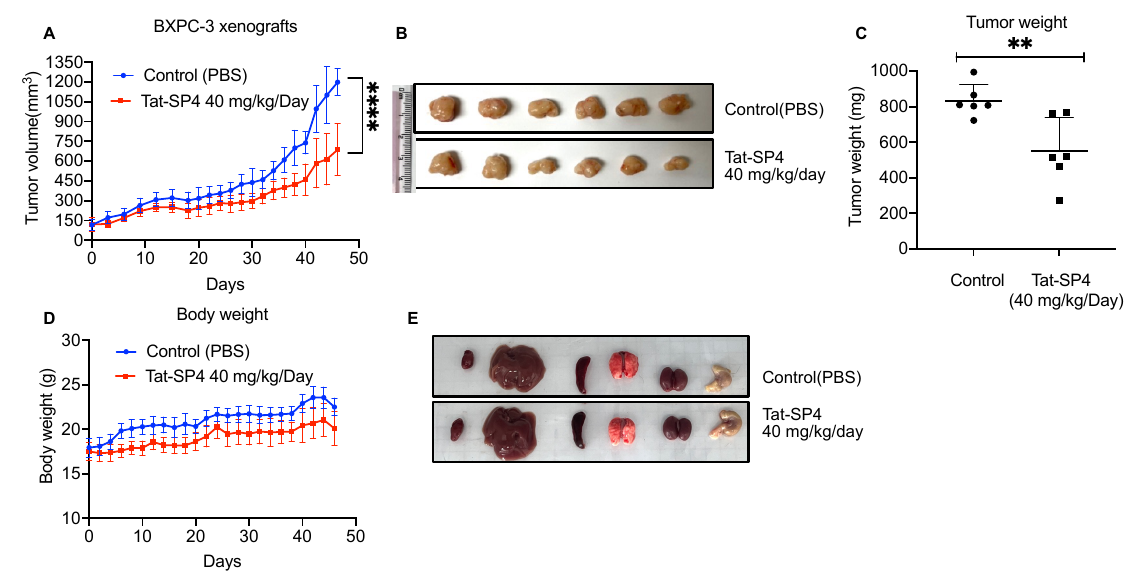
Figure 6. Tat-SP4 inhibited PDAC tumor growth in a xenograft model. ( A ) BxPC-3 cells were subcutaneously injected into nude mice in a number of 5 × 10 6 . The administration of 40 mg/kg Tat-SP4 or PBS (control) was started when the tumor volume reached 100 mm 3 . The tumor volume was recorded from the initial treatment to tumor harvest (Day 46). The tumor volume was defined as width 2 × length/2. Data are presented as mean ± SEM; n = 6; **** p < 0.0001. ( B ) Picture of the dissected BPxC-3 tumor tissues from each mouse. ( C ) The tumor weight was measured after collection on day 46. Data are presented as mean ± SEM; n = 6; ** p < 0.01. ( D ) The development of body weight in mice after receiving the treatment of 40 mg/kg Tat-SP4 or PBS. Data are presented as mean ± SEM; n = 6. ( E ) The representative pictures of harvested vital organs from both control and treatment